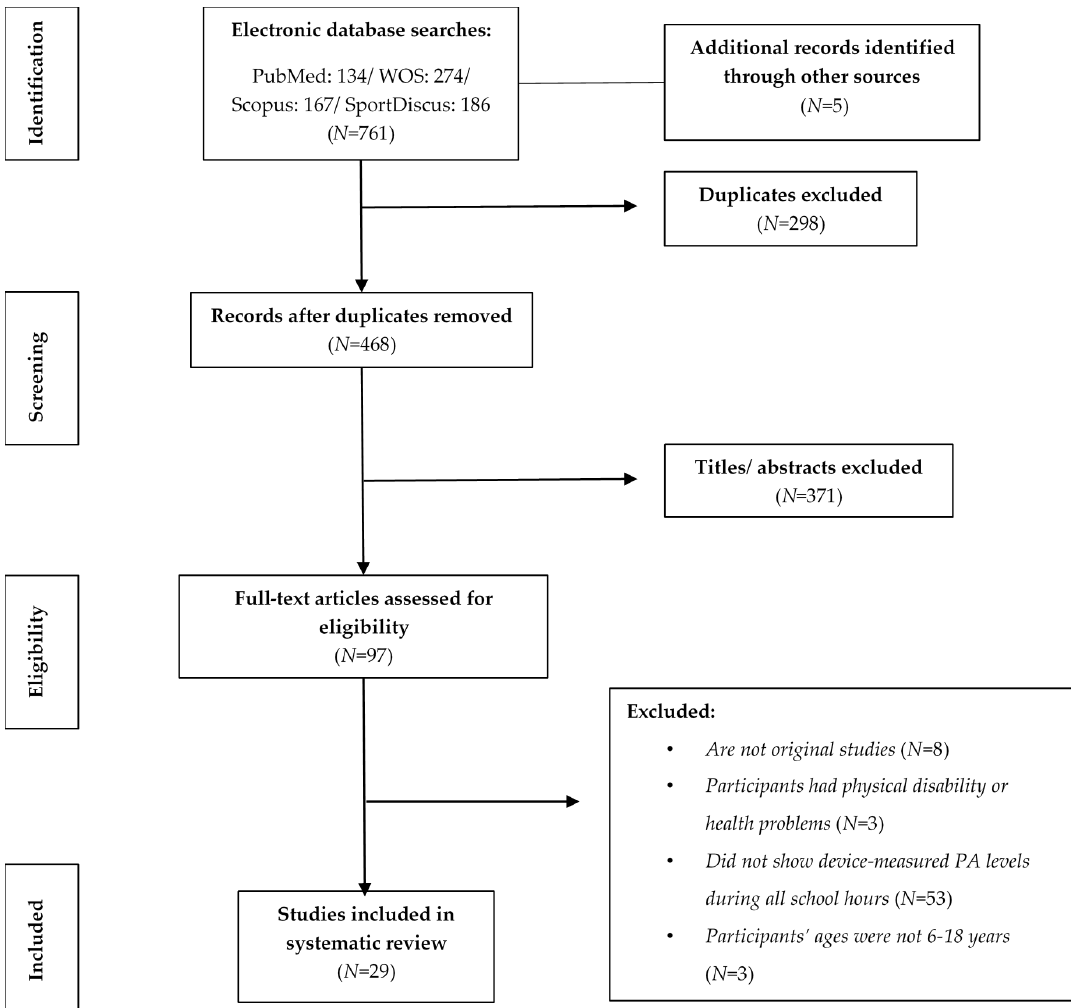
Figure 1. Flow of articles through the search process.